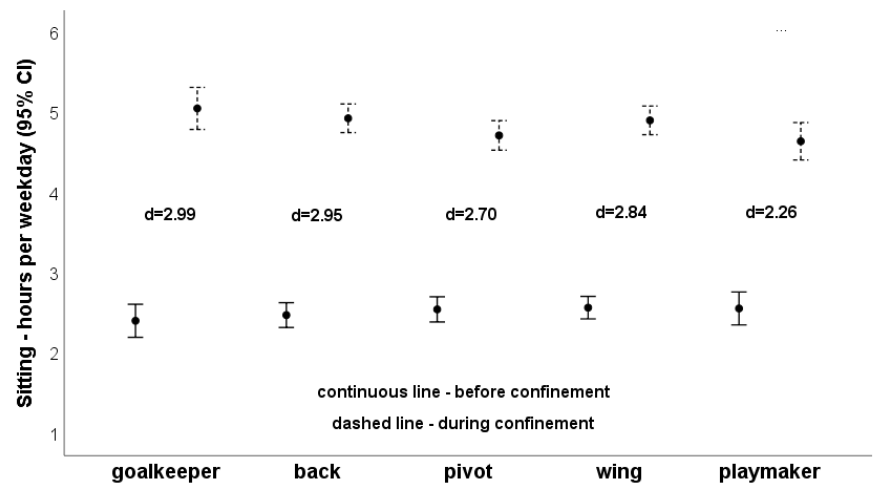
Figure 1. Sitting hours per weekday depending on playing positions.